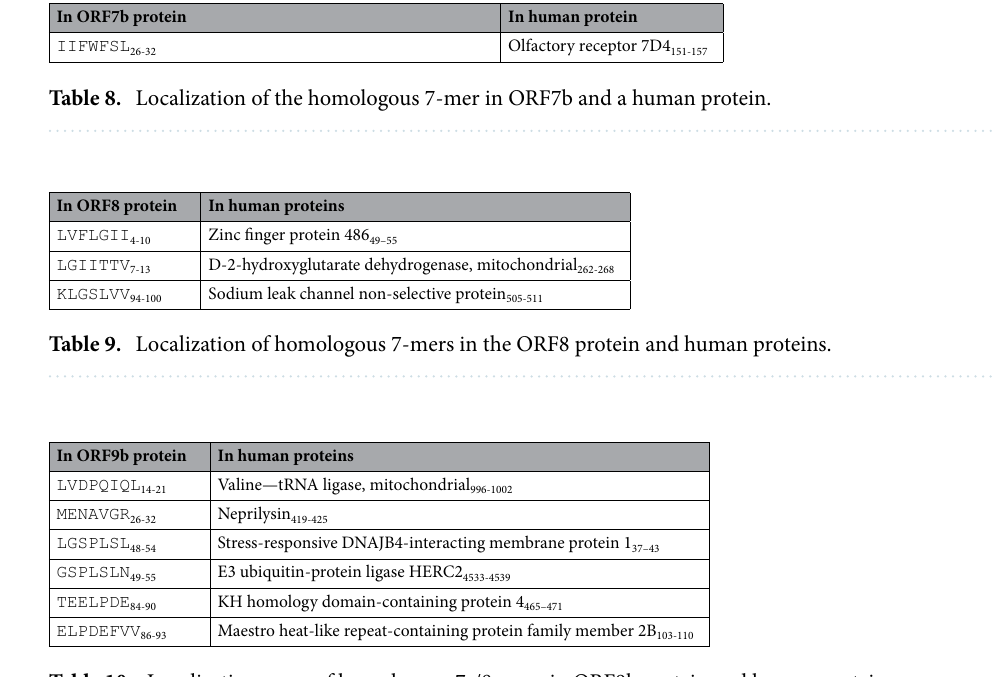
Table 10. Localization some of homologous 7-/8-mers in ORF9b protein and human proteins.